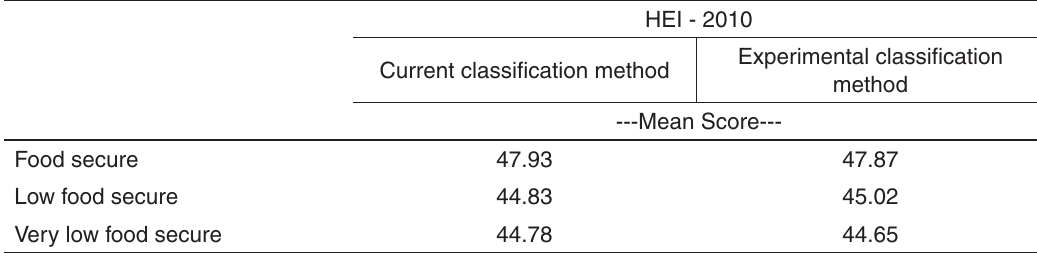
Healthy Eating Index score by food-security-status classification method, adults in households with children, NHANES